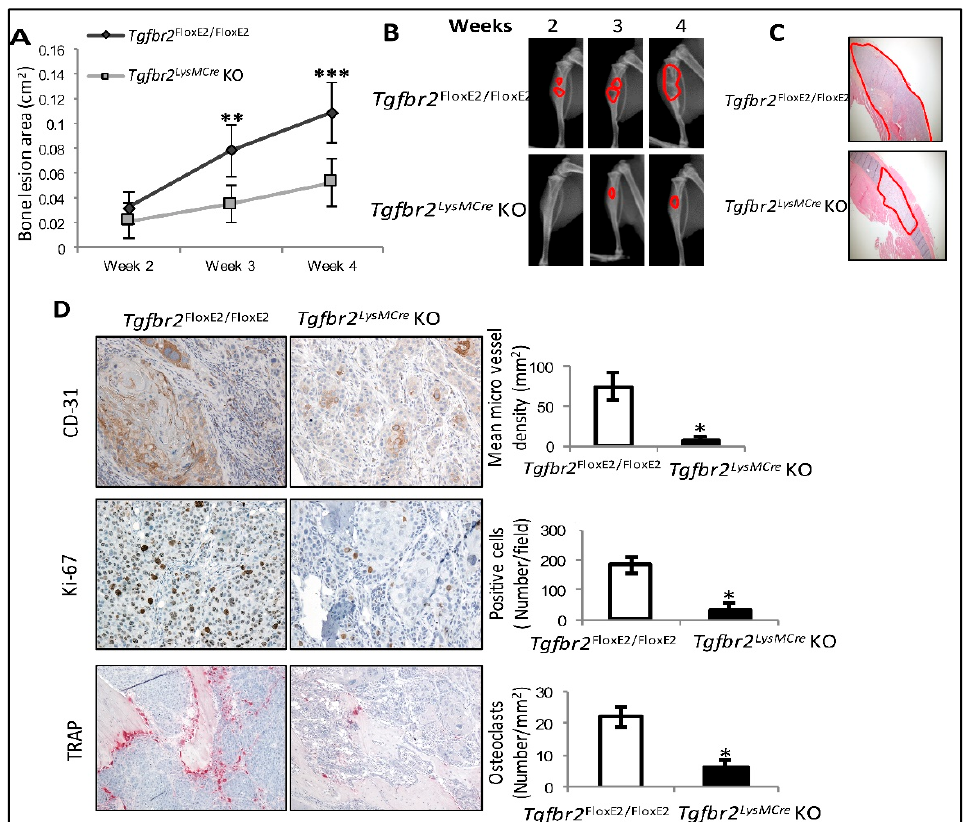
Figure 1. H1993-induced bone lesions were inhibited in Tgfbr2 LysMCre knockout (KO) mice. A. Quantification of bone lesion areas in the control and KO mouse tibiae. B. Representative bone lesions (red outlines) shown by weekly X-ray images. C. Hematoxylin and eosin (H&E) staining images (4×) confirm tumor growth in the mouse tibiae (red outlines) at 4 weeks (wk) post-injection. D. Representative mouse tibiae at 4 wk post-injection, stained for CD31 (20×), Ki67 (20×), or TRAP (10×). Mean ± SD, n ≥ 10 per group. *** p < 0.001, ** p < 0.01, * p ≤ 0.05, by linear mixed-effect models for bone lesions and Student’s t -test for paired comparison.